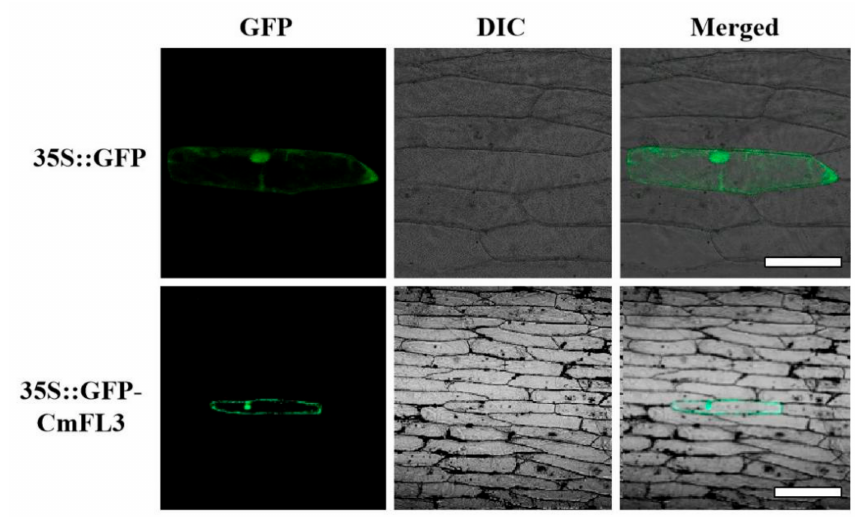
Figure 3. Subcellular localization of CmFL3. GFP, green fluorescence protein; DIC, differential interference contrast; Merged, overlay plots. Bars = 50 µ m.